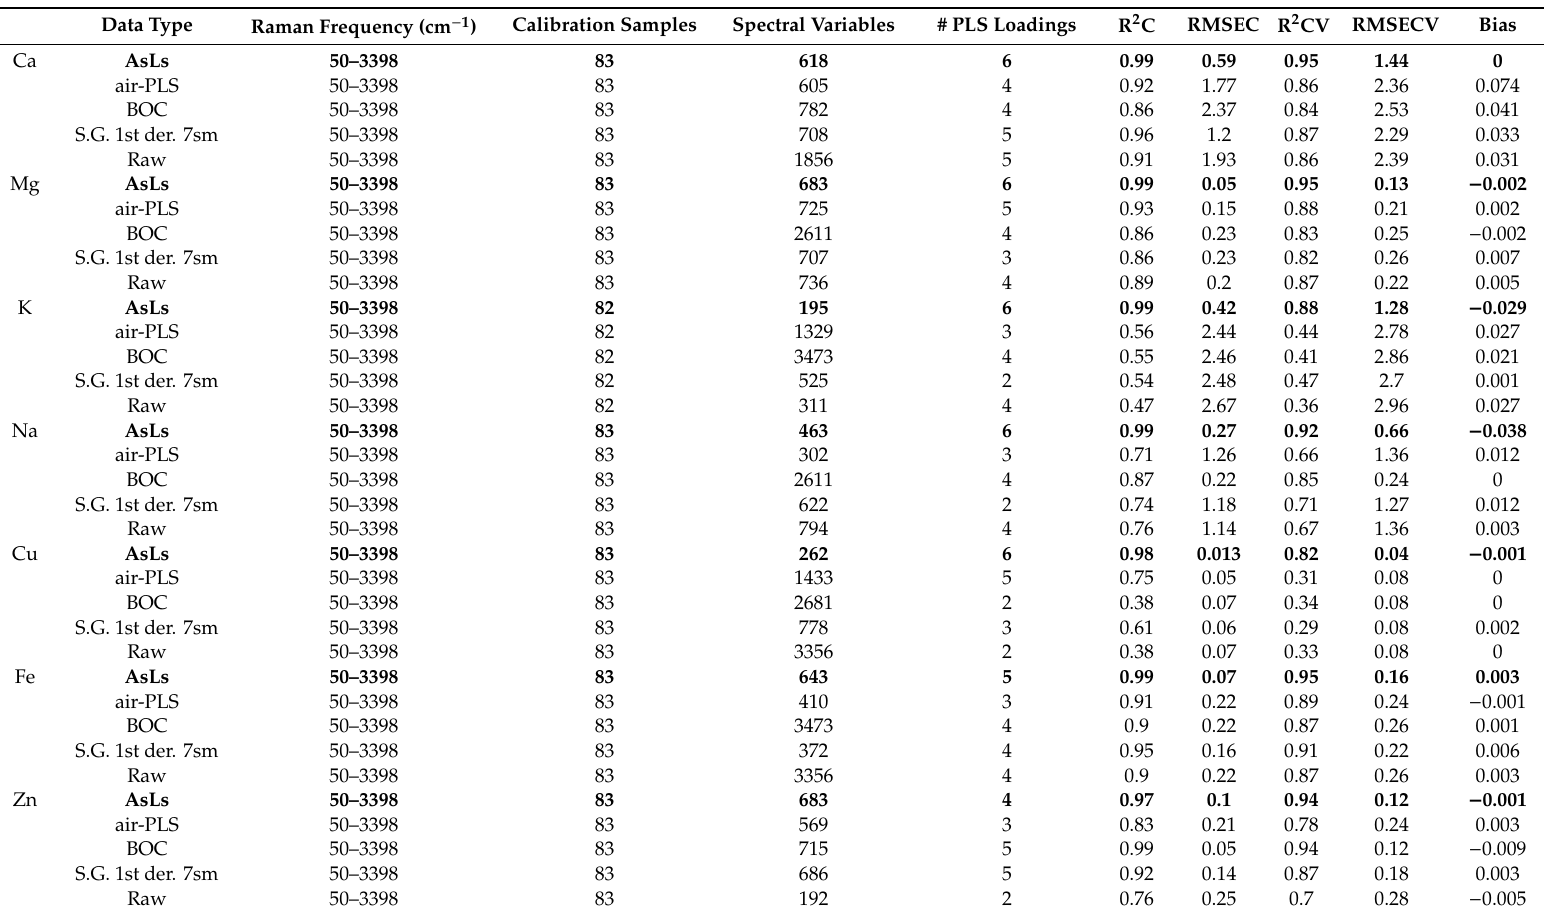
Table 3. Summary of venetian blinds cross-validation PLSR performances (Raman frequency: 50–3398 cm − 1 ) for mineral elements prediction. (most accurate models in